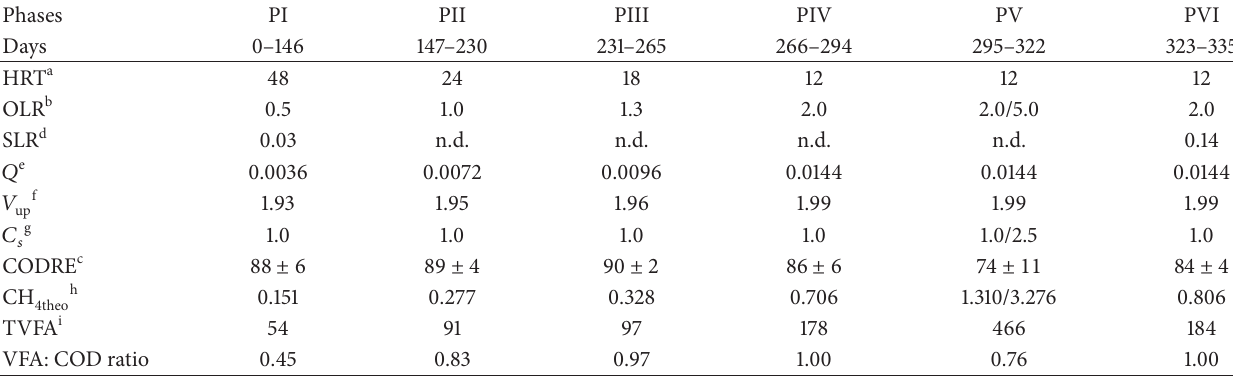
Table 1: Operational and performance characteristics during phases I to VI of the bioreactor